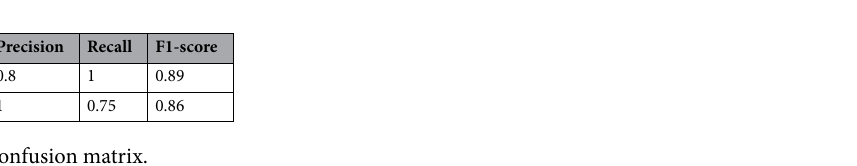
Table 7. Confusion